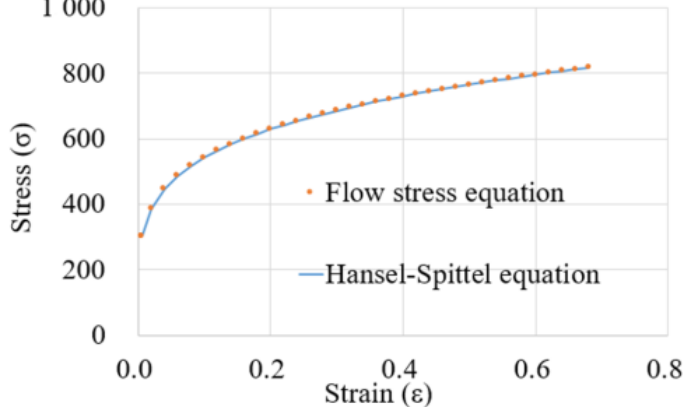
Table 3. Coefficient of Hansel – Spittel equation for 34CrMo4.